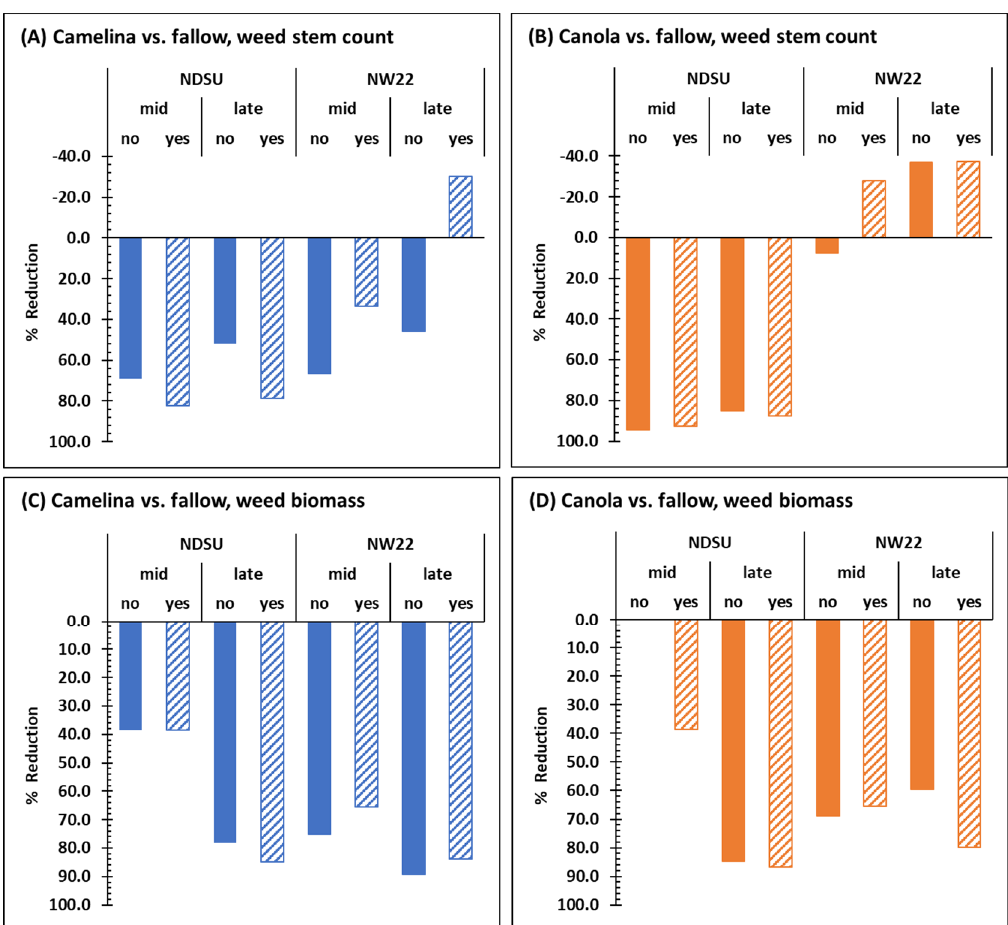
Figure 3. Summary comparison of mid- and late-season reduction (%) based on mean weed stem counts ( A , B ) and biomass dry weights ( C , D ) in field plots of sulfonylurea-resistant camelina ( A , C ) and canola ( B , D ) treated without (no) or with (yes) herbicide with that of mid- and late-season mean weed stem counts and biomass dry weights of fallow plots at NDSU and NW22. Fallow plots were not treated with herbicide.